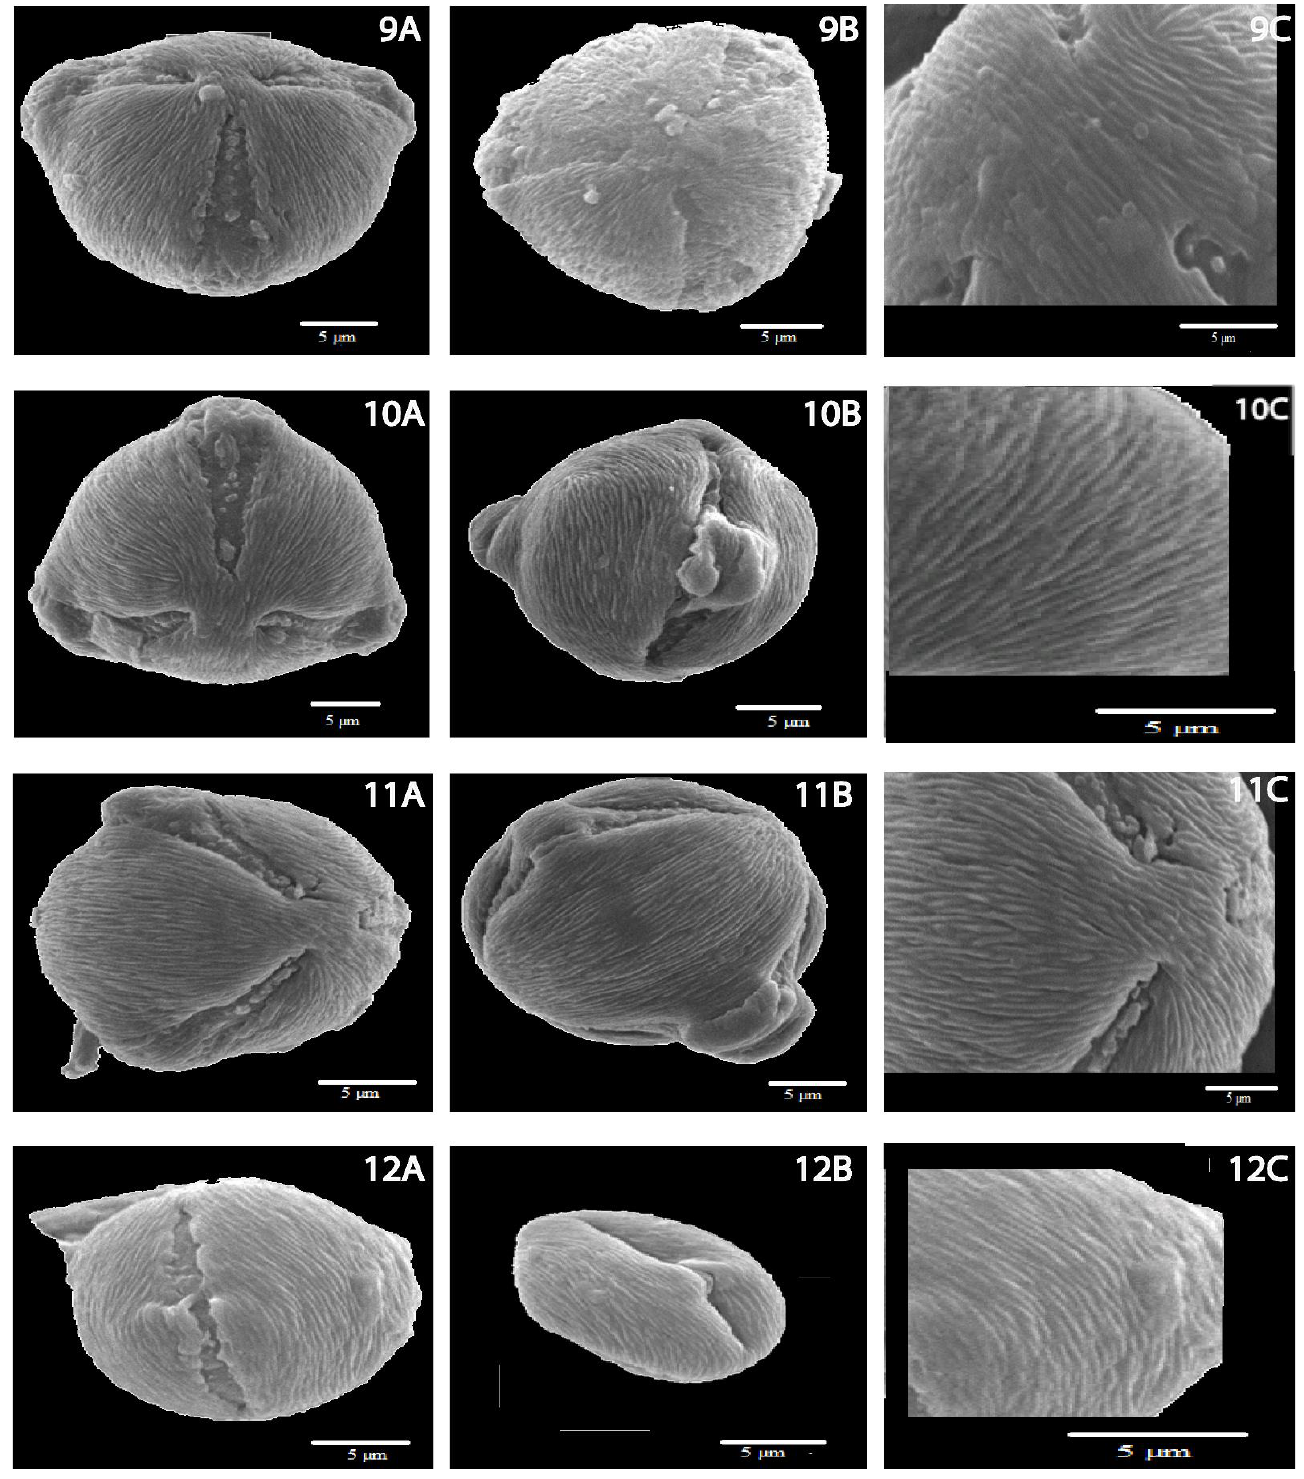
Figure 4. ( A , B ). Different shapes of pollen ( C ). surface 16639- (9A – 9C ) R. omeiensis , 16676-( 10A – 11C